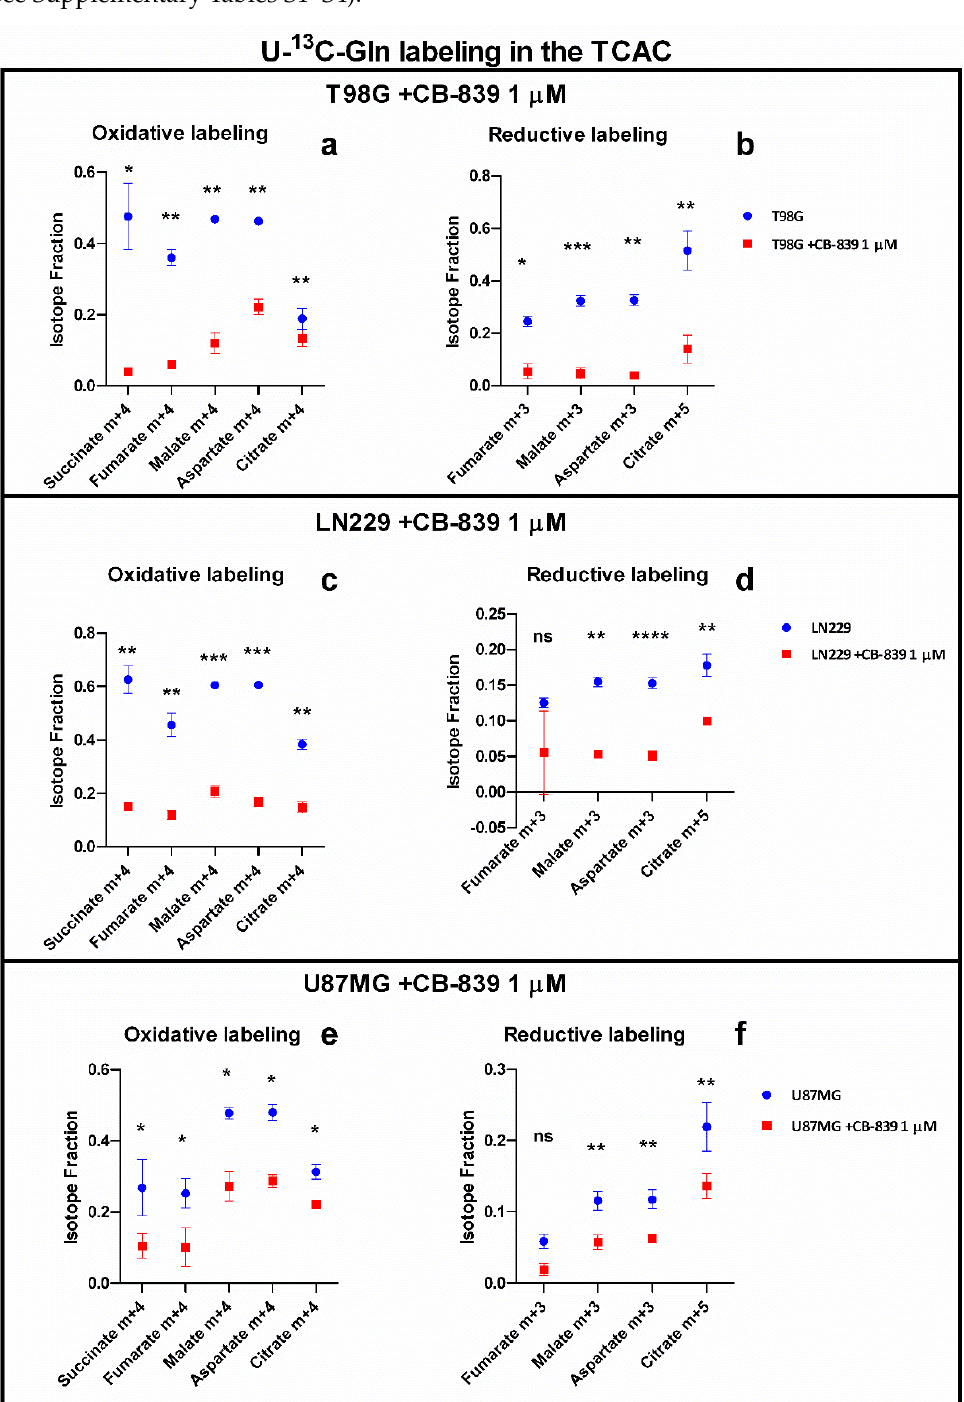
Figure 3. Isotopic tracing in T98G, LN229, and U87MG showing oxidative ( a , c , e ) and reductive ( b , d , f ) associated labelling in the TCAC. Results are shown as the isotopologue fraction referred to the total metabolite. The samples were run in triplicate. For more details, see Section 2. ns—non-significant. * p < 0.05, ** p < 0.01, *** p < 0.001, **** p < 0.0001.